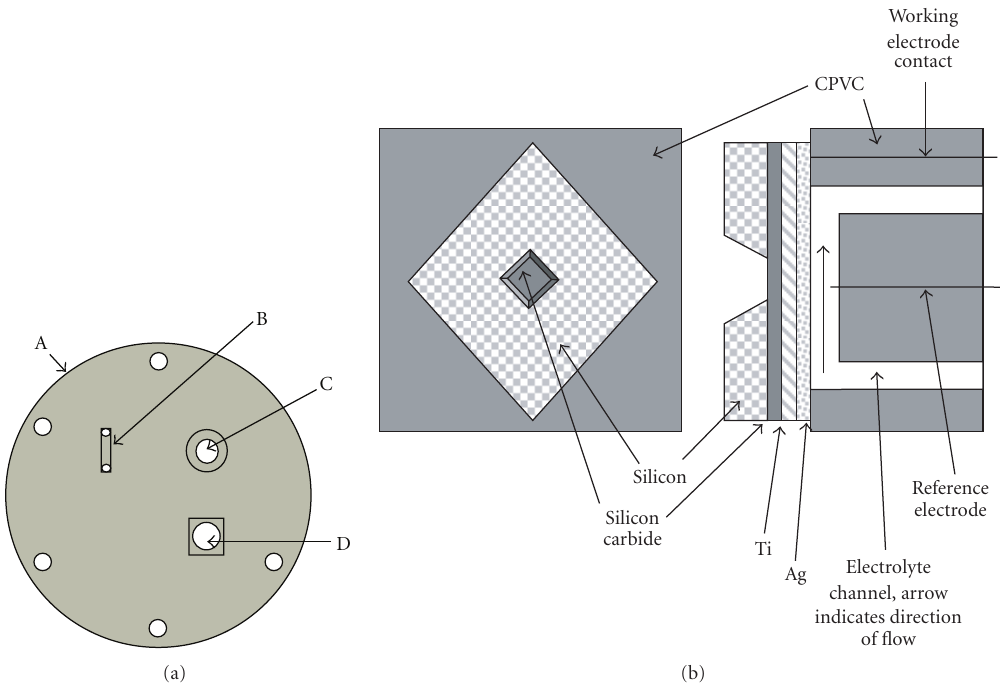
Figure 2: (a) Electrochemical cell for radiolysis measurements. A: 2.75 (cid:4)(cid:4) Conflat blank flange, machined from CPVC block. B: electrolyte channel—1cm long, 2 mm wide, 2mm deep. C: recess for Faraday cup. D: recess for quartz window. (b) Detailed view of Electrochemical cell for radiolysis measurements. Drawing not to